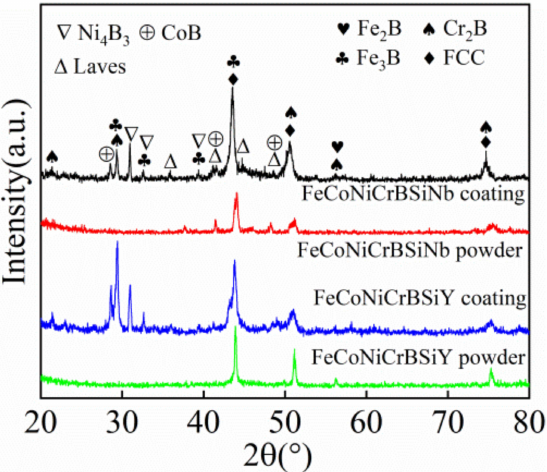
Figure 3. X-ray diffraction (XRD) patterns of powder and laser cladding